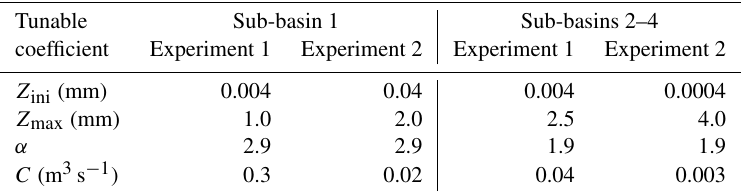
Table 5. Tuned coefficients of WRF-Hydro/aquifer law for Experiment 1 and 2. Z ini is the initial value of the aquifer water depth, Z max is the maximum value of the aquifer water depth, α is the exponential law coefficient, C is the volume capacity of the aquifer. Different optimal values are set depending on sub-basin and season.